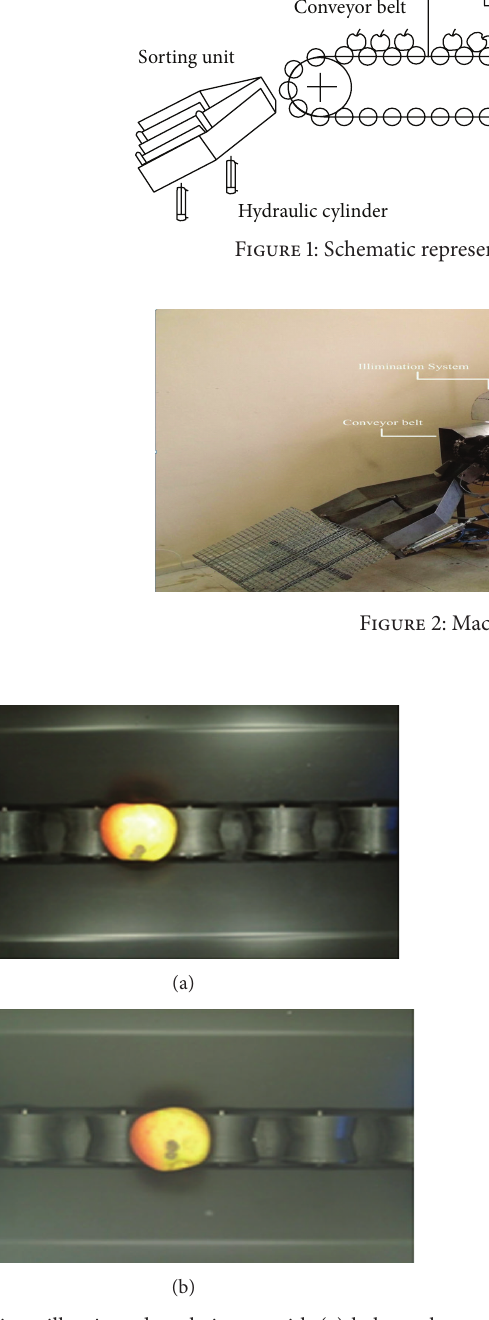
Figure 4: The masking results of illuminated apple image with (a) halogen lamps, (b) fluorescent lamps.